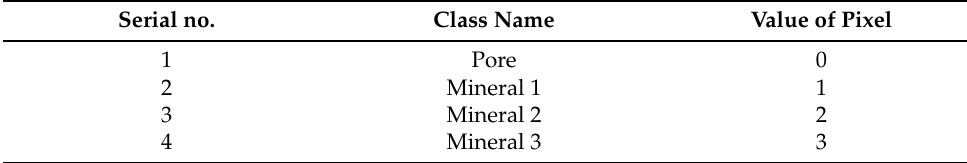
Table 1. Details of our dataset labeling. Serial